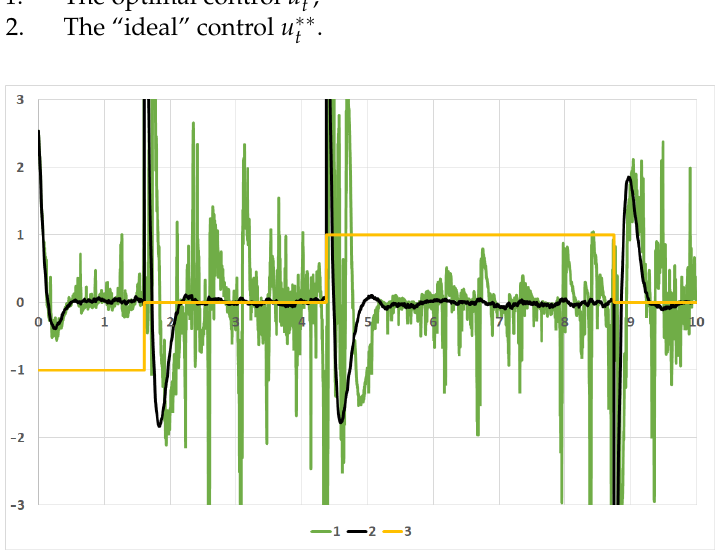
− u ∗∗ − target C y t t , 2 t , and 3